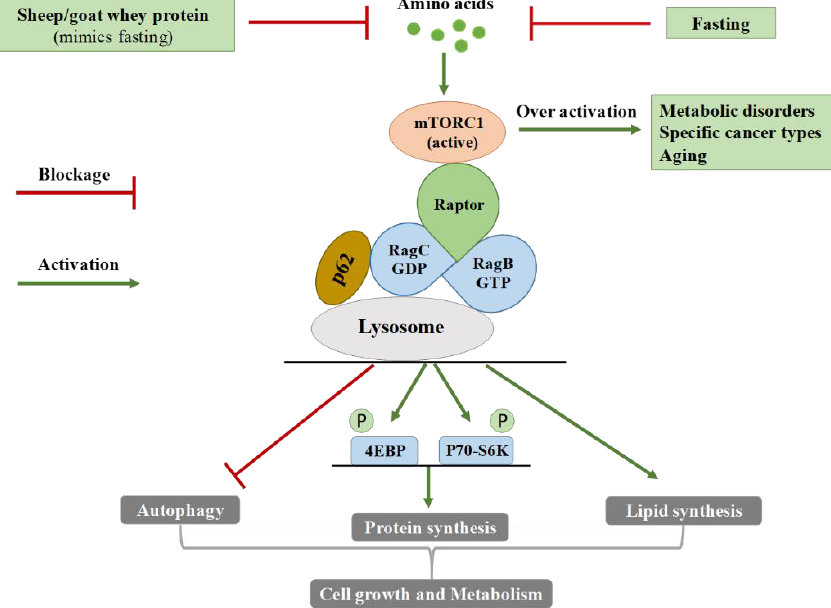
Figure 5. The molecular pathway of amino-acid-related (over) activation of mammalian target of rapamycin complex 1 (mTORC1) and the beneficial action of sheep/goat whey protein administration that mimics fasting. mTOR regulates diverse cellular processes, such as cell growth and proliferation, autophagy and protein synthesis and exists in two forms; mTORC1 and mTORC2. Two well-known substrates of mTORC1 are p70-S6 Kinase 1 (p70-S6K1), whose expression was measured in the present study and the eukaryotic initiation factor 4E-binding protein 1 (4EBP1). When they are phosphorylated, mRNA translation and, subsequently, protein synthesis are enhanced. The adaptor p62 is an important signaling molecule for the physiological function of mTORC1 since it interacts with signaling intermediates and activates S6K1 and 4EBP1. Whey protein, similar to fasting, inhibits the overactivation of mTOR and, therefore, exerts a potential protective role against diverse pathologies.